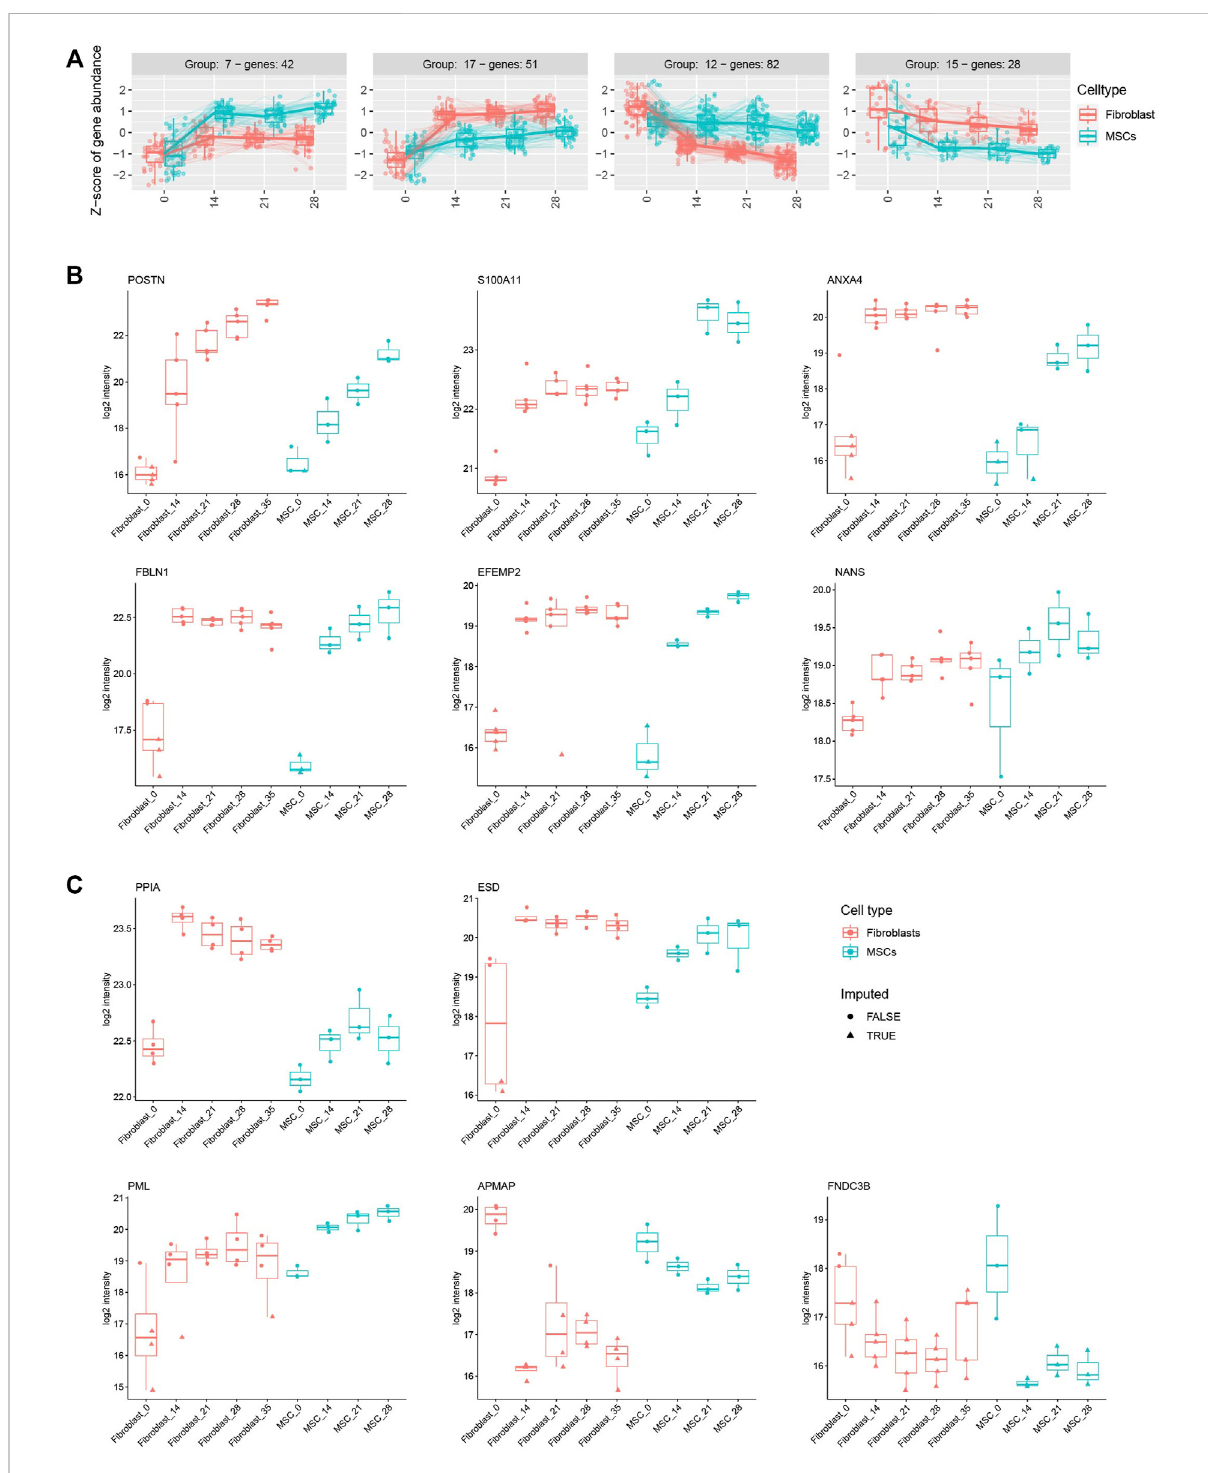
FIGURE 6 Osteoblastic differentiation treatment induces similar gene and protein pro fi les in fi broblasts and MSCs. (A) Four clusters of up and down- regulatedgenesinbothcelltypesduringtheosteoblasticdifferentiation.Intotal,42genesingroup7and51genesingroup17areup-regulatedwhile 82 genes in group 12 and 28 genes in group 15 are down-regulated. Clusters include all signi fi cantly differentially expressed genes with a p_adj. < 0.05inanyofthetimepointsfromthecourseanalysis. (B) ProteinexpressionofPOSTN,S100A11,ANXA4,